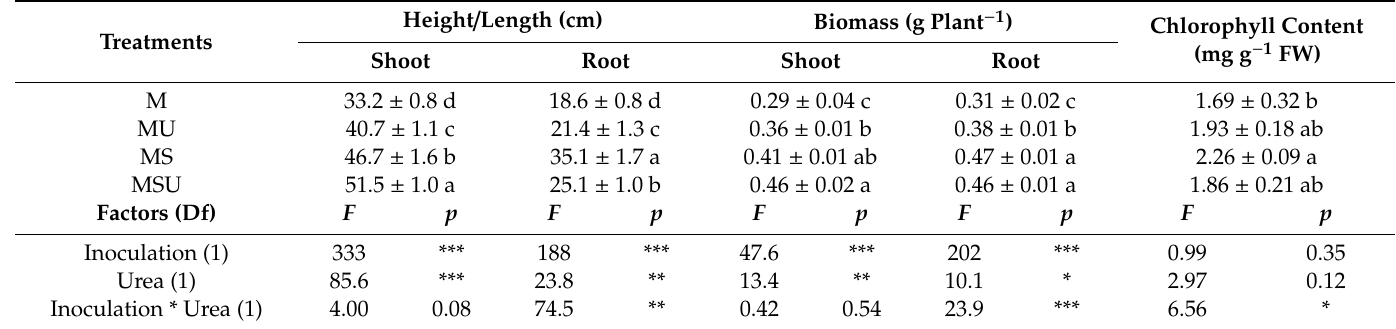
Table 3. The height / length, biomass, and chlorophyll content in plants under di ff erent treatments. Height / Length (cm) Treatments